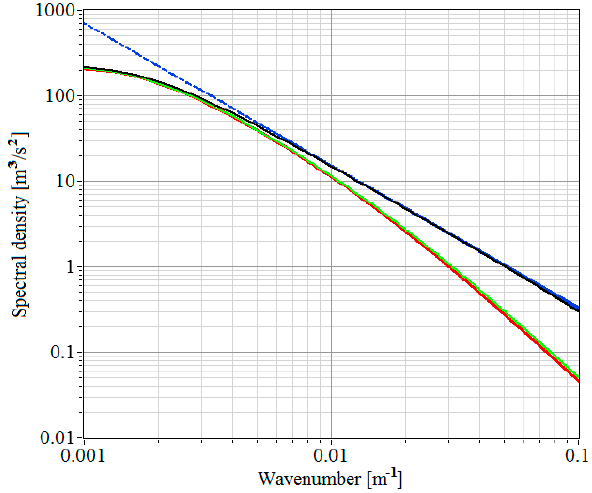
Figure A1. Transverse spectra of the radial velocity S r ( κ ) (black curve), S max ( κ ) (green curve), and S a ( κ ) (red curve). The blue dashed curve is for the Kolmogorov–Obukhov “ − 5/3”